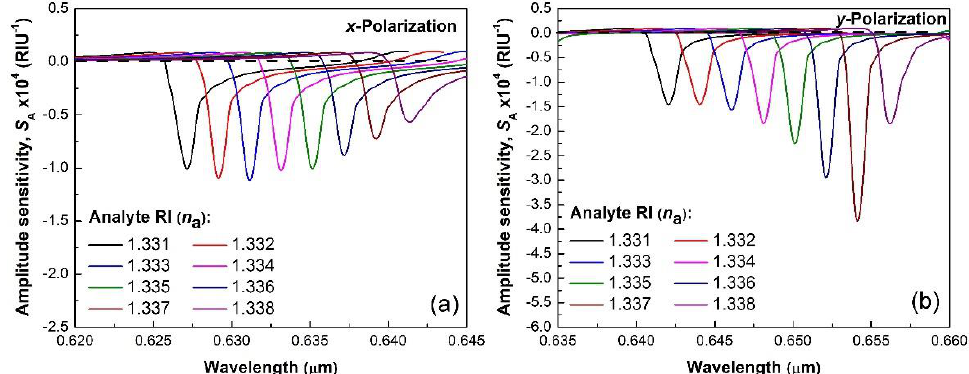
Figure 7. The wavelength-dependent amplitude sensitivity for different analyte RI: ( a ) x and ( b ) y polarized modes for the graphene layer thickness of 40.12 nm.